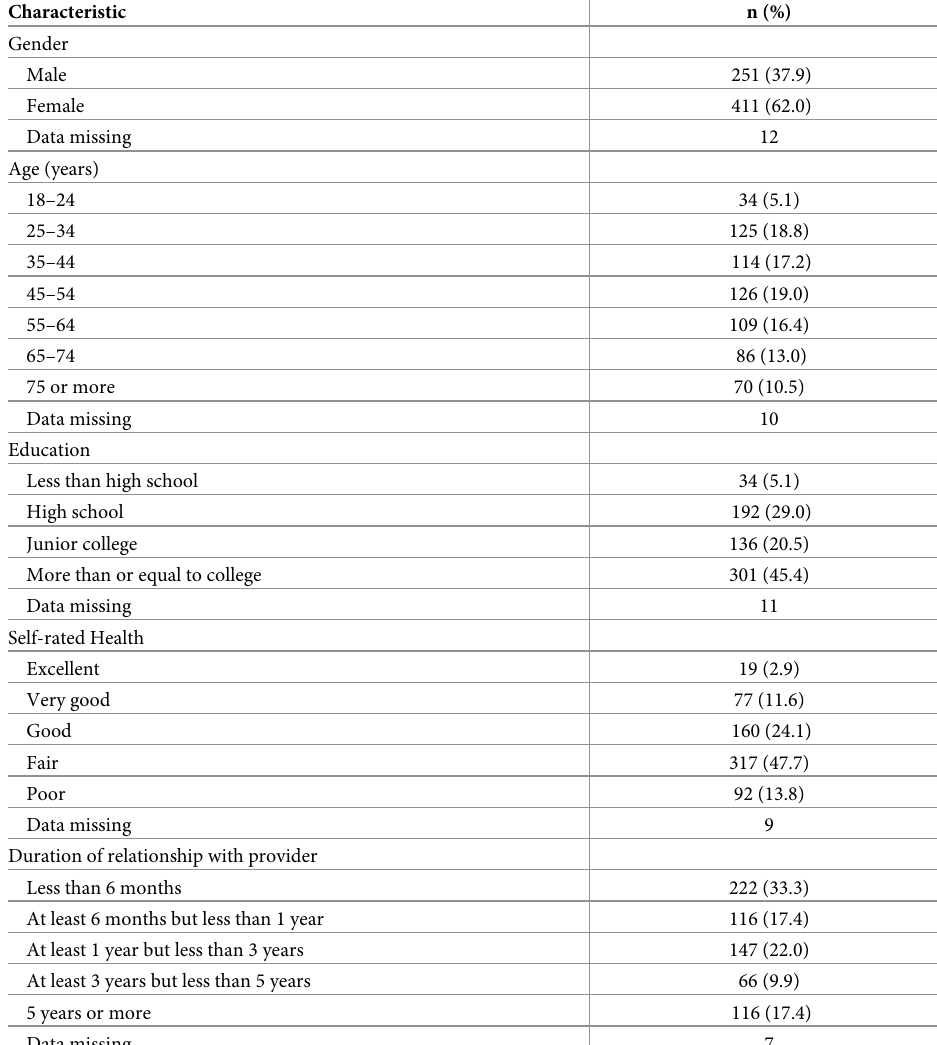
Table 1. Participants’ characteristics (N =